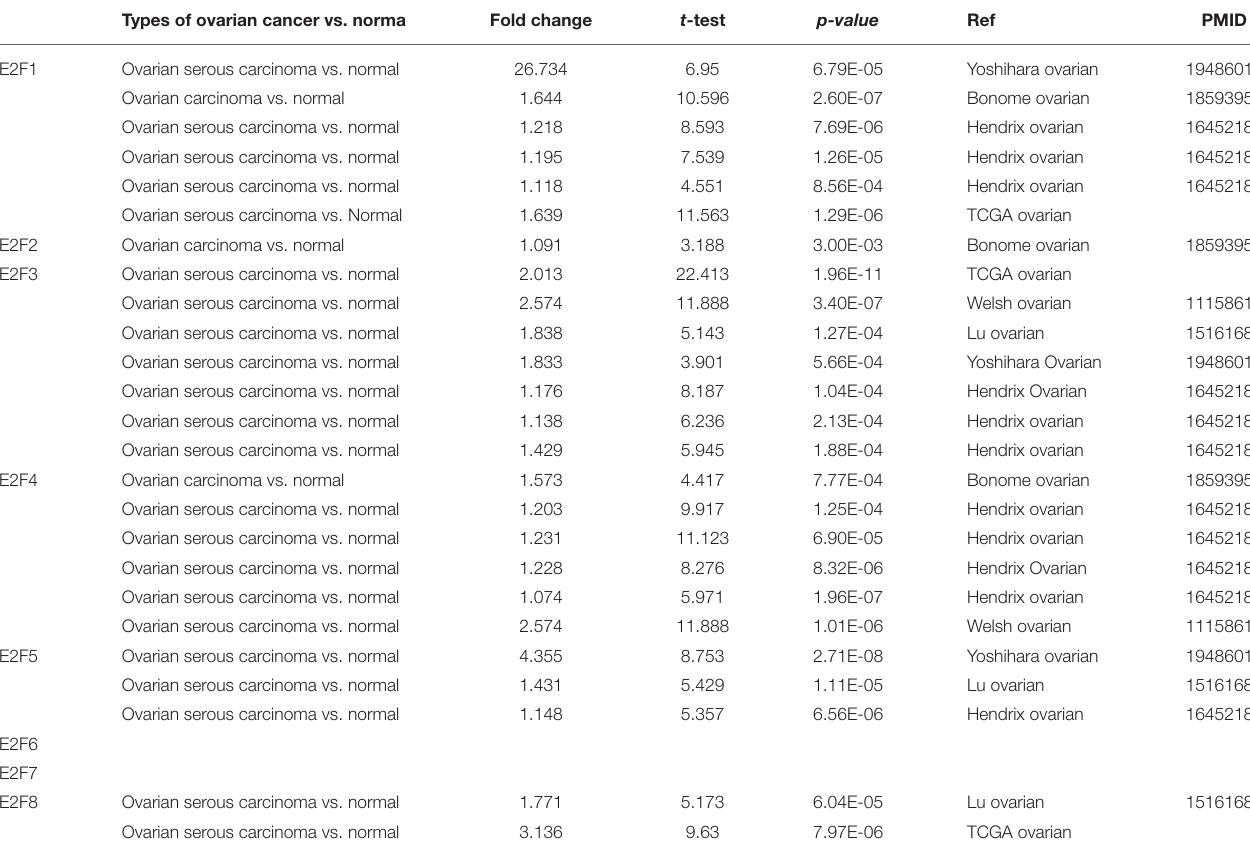
TABLE 1 | The transcription levels of E2F family members in between different types of OC and ovarian normal tissues (ONCOMINE). Types of ovarian cancer vs. norma Fold change t -test p-value